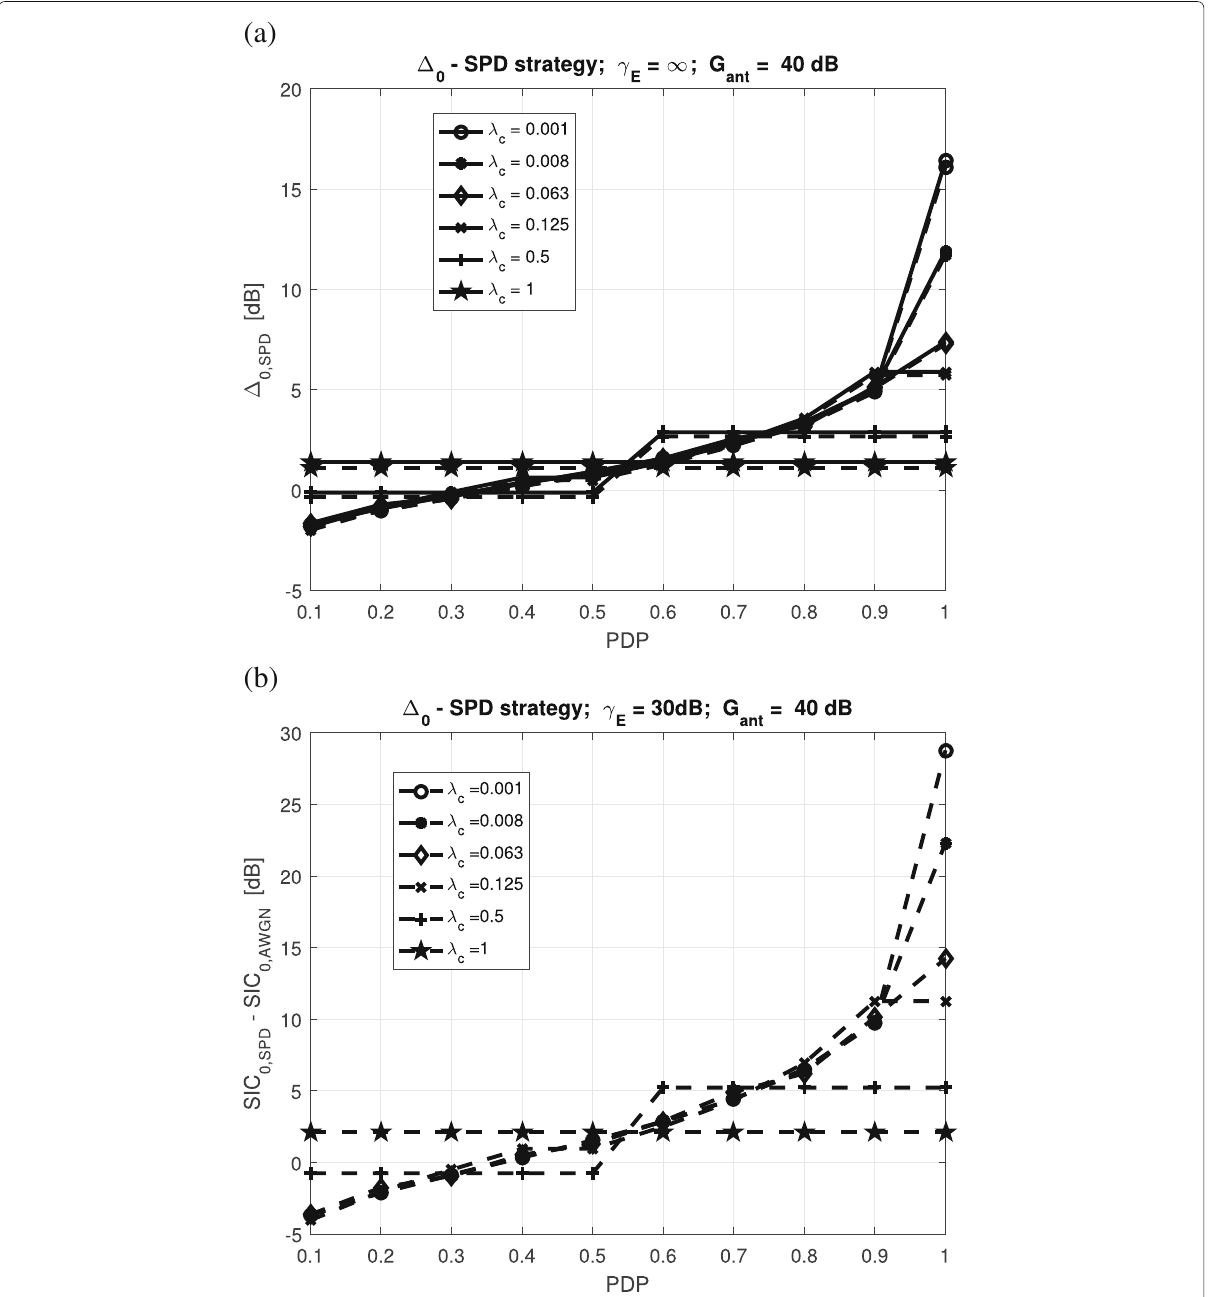
Fig. 5 Margin (cid:9) 0,SPD for frequency selective Rayleigh channel model. a Margin (cid:9) 0,SPD [dB] vs. the parameter PDP with γ E = ∞ and G ant = 40 dB, for different frequency selectivity values λ C . Continuous lines are derived analytically and dashed lines from simulations. b Margin (cid:9) 0,SPD taking into account non-idealities and leakage into the model ( γ E = 30 dB). The results are derived by simulating the Rayleigh fading